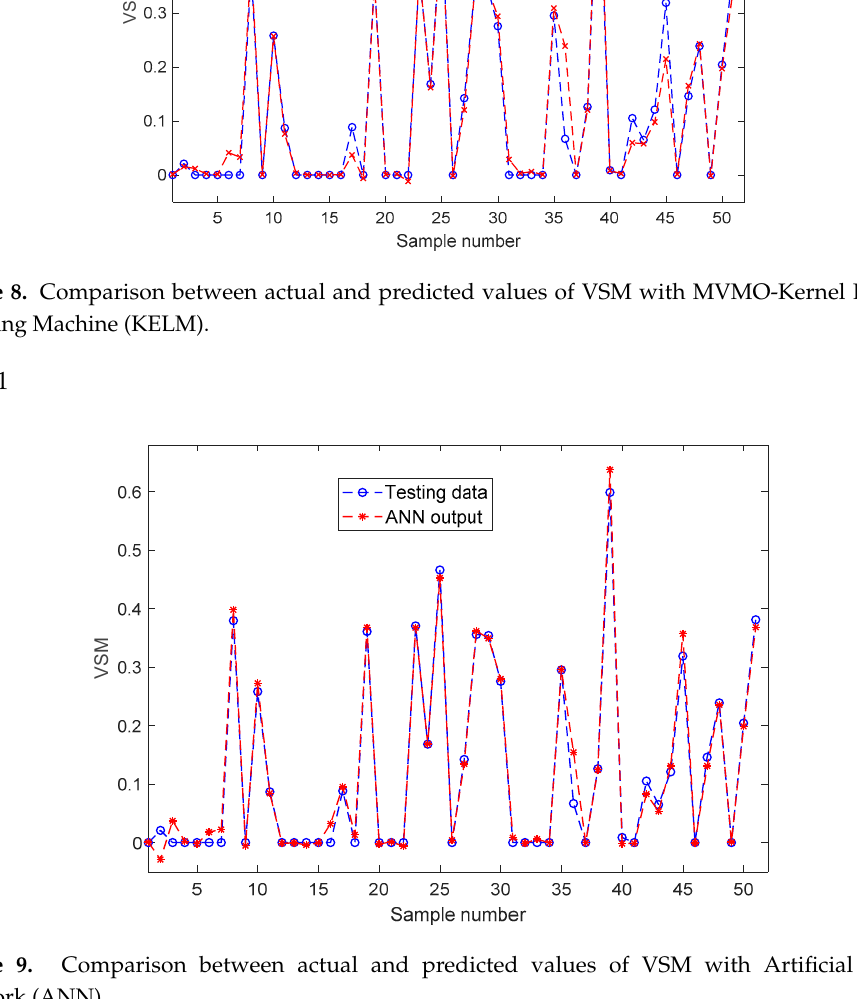
Figure 9. Comparison between actual and predicted values of VSM with Artificial Neural Network (ANN).